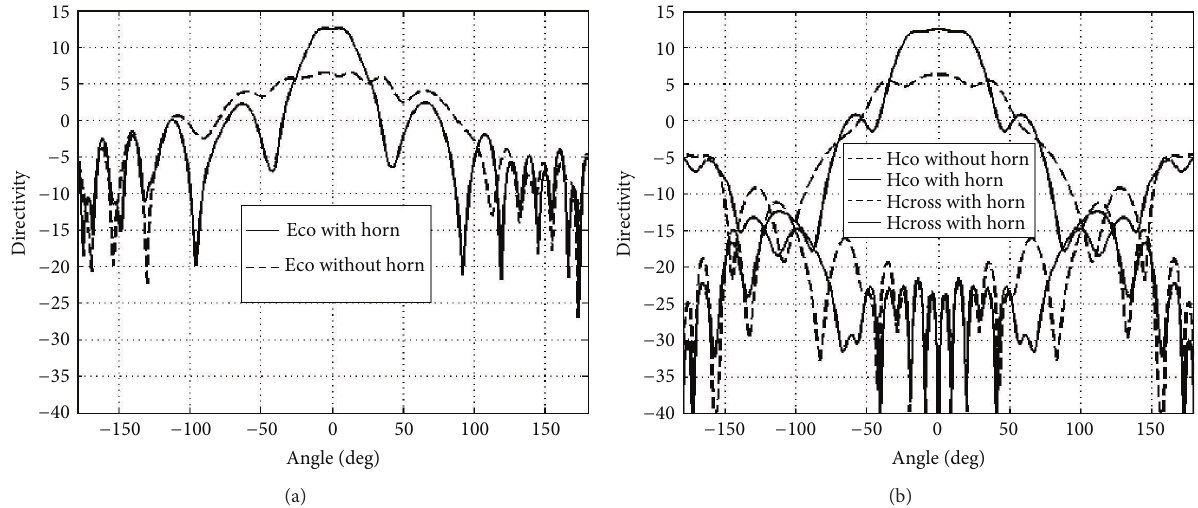
Figure 5: (a) Simulated 𝐸 -plane radiation pattern with and without Horn. (b) Simulated 𝐻 -plane radiation pattern with and without Horn.